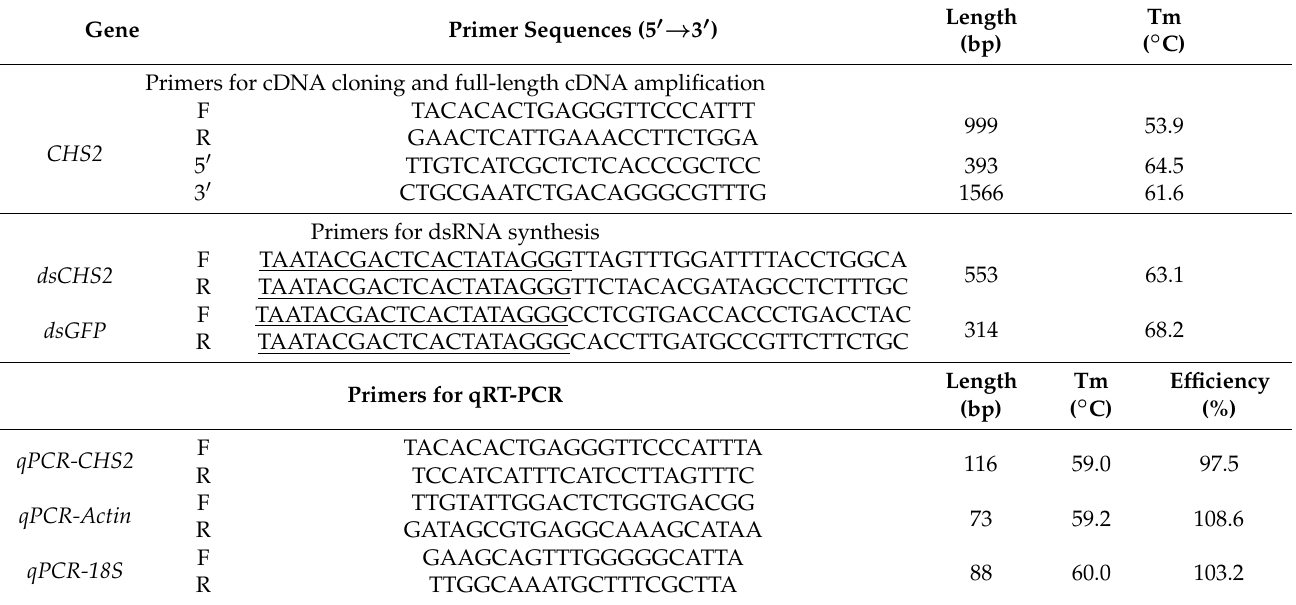
(Table 1), 2 µ L of cDNA template, and 6 µ L of ddH 2 O as described [32]. Reactions